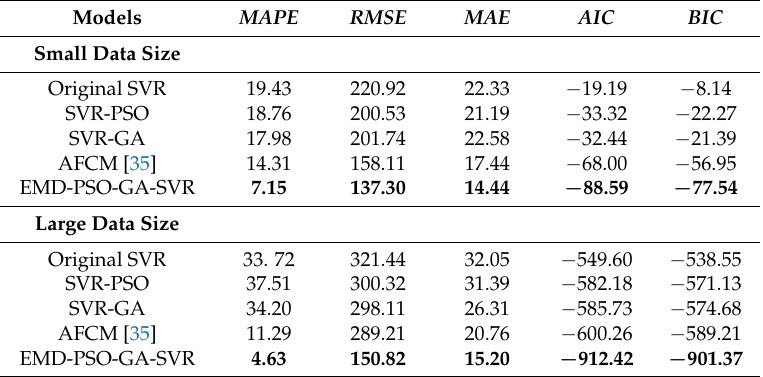
Table 8. Forecasting performances of competitive models for both small and large data sizes (Example 2).